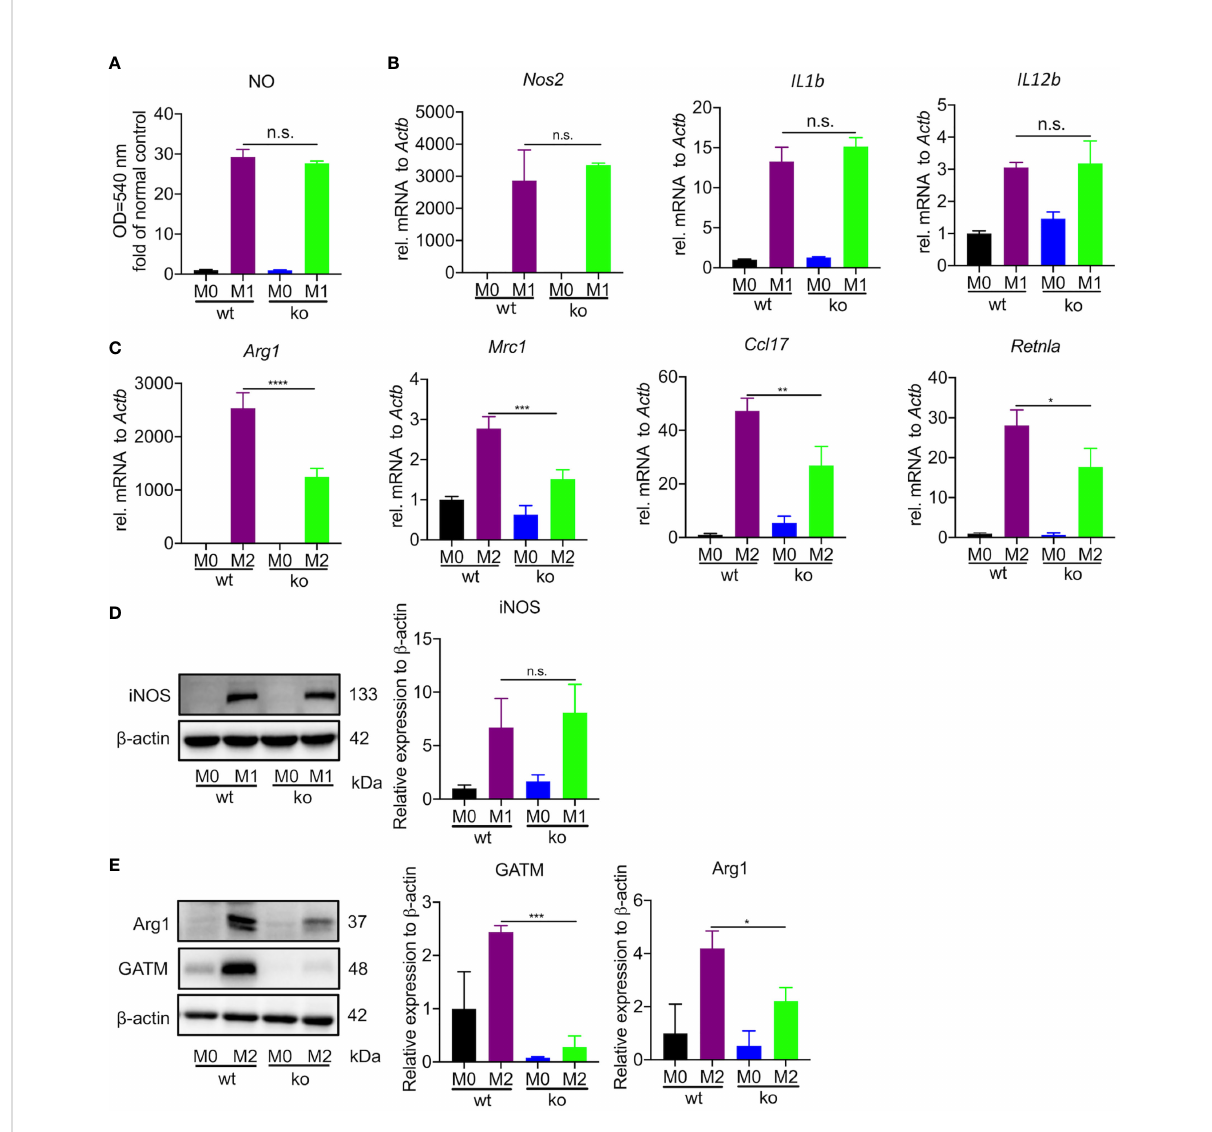
FIGURE 2 GATM promoted M2 polarization in BMDMs but had only a small effect on M1 polarization. (A, B) , GATM -/- BMDMs were activated with LPS and IFN- g for 24 hours. Level of NO and Nos2, IL1b and IL12b mRNA expression was determined by quantitative PCR (n=3). (C) GATM -/- BMDMs were treated with IL-4 activation for 24 hours. Arg1, Mrc1, Ccl17 and Retnla mRNA expression was determined by quantitative PCR (n=3). (D, E) , GATM -/- AMs were treated with LPS and IFN- g or IL-4 activation for 24 hours. iNOS and Arg1 protein expression was determined by western blotting (n=3). Data are expressed as mean ± SEM. Statistical signi fi cance was determined using one-way ANOVAs with Tukey ’ s multiple comparisons test; n.s., not signi fi cant; * P <0.05, ** P <0.01, *** P <0.001, **** P